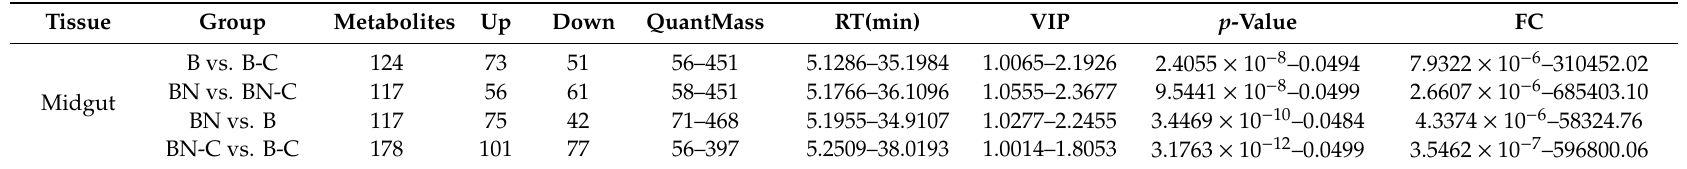
Table 2. Metabolites of di ff erent silkworm varieties midgut tissues.